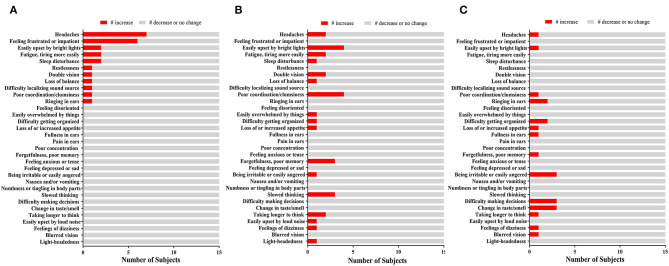
The Effect of OP Exposure on Symptom Reporting. Bar chart indicating the number of participants (x-axis) and self-reported symptoms (y-axis) on (A) Day 1, (B) Day 2, (C), and Day 3. Those who reported an increase (red) compared those who did not (gray) are shown.